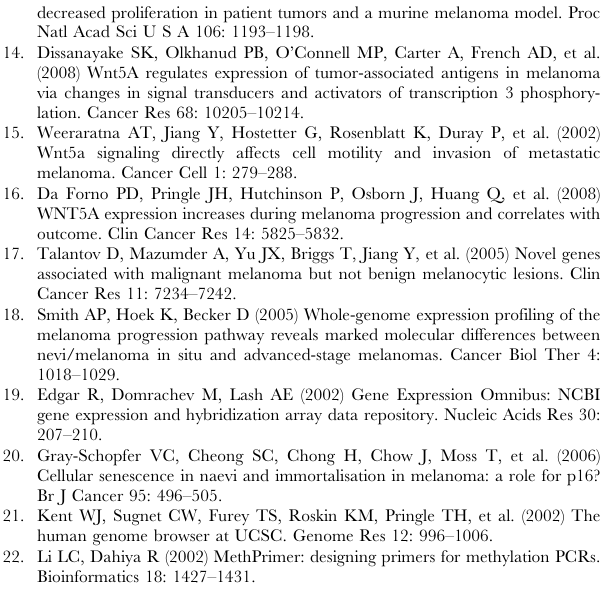
Figure S2 Fluorescence intensity measurement of SFRP3 protein expression after demethylation treat-